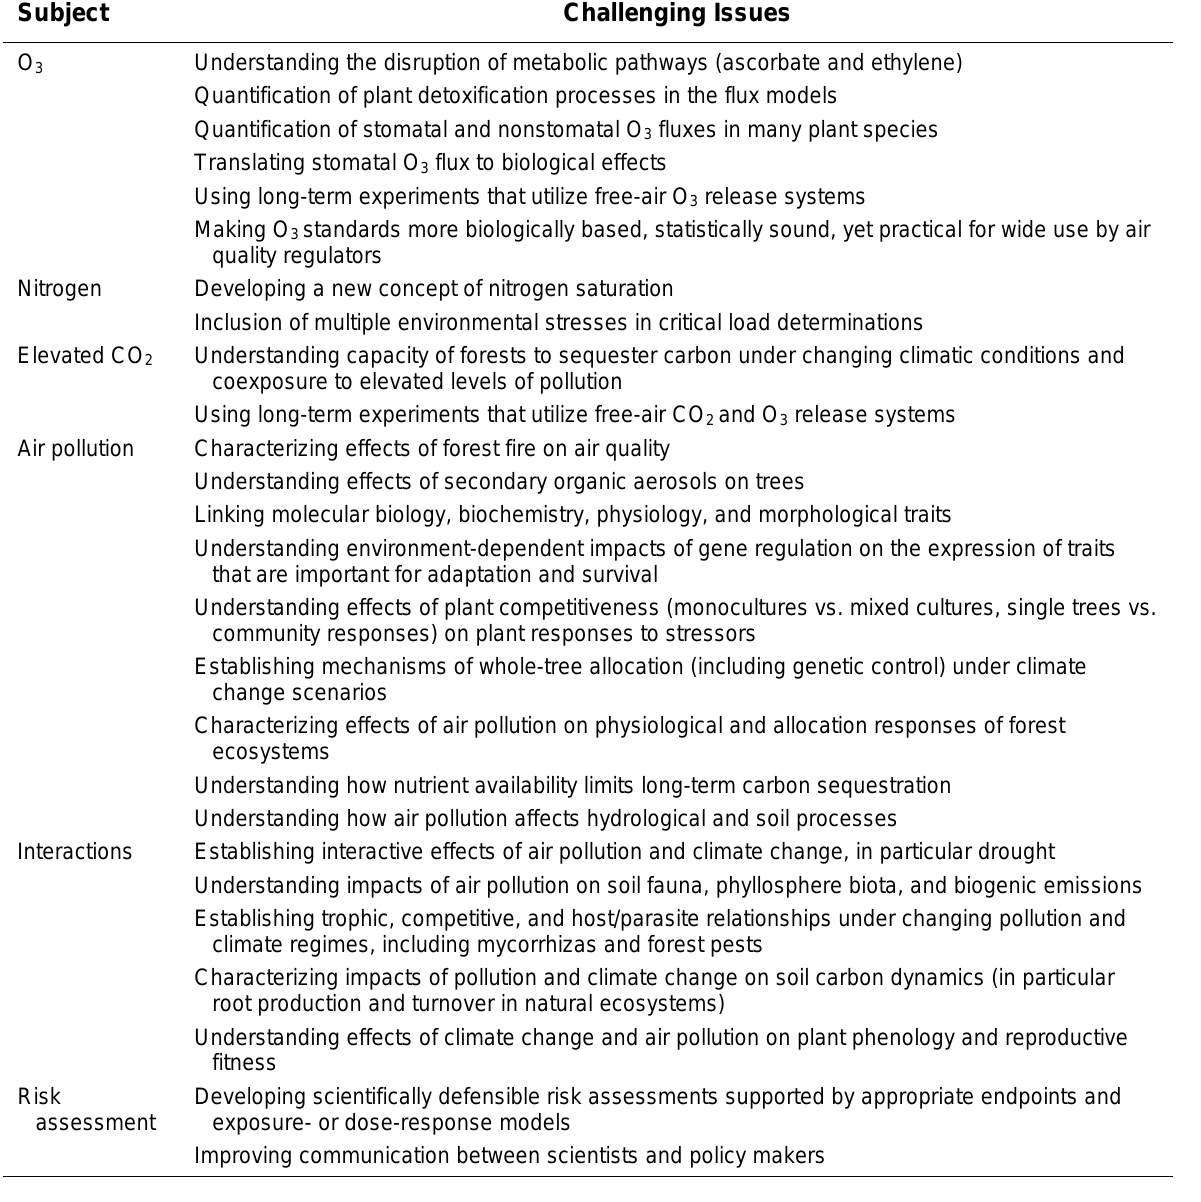
Emerging Research Issues at the 22 nd Meeting for Specialists in Air Pollution Effects on Forest